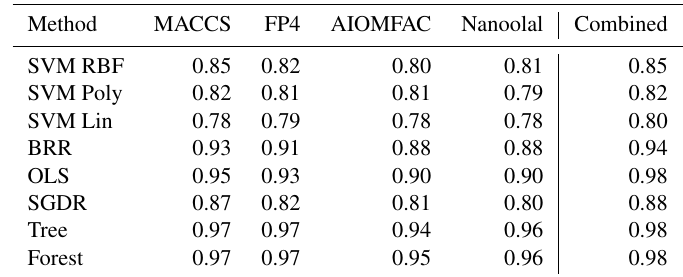
Table 2. Median cosine angle between measured and predicted spectra, using 80% of the compounds in the training process, with variable selection, as a function of molecular fingerprint (given above each column). Please note that the term “Combined” refers to a combination of all individual fingerprints into one. The method labels are as follows: SMV (support vector machine with three kernels (RBF, Poly(nomial) and Lin(near))); BRR: Bayesian ridge; OLS: ordinary least squares; SGDR: stochastic gradient descent; Tree: decision tree; and Forest: random